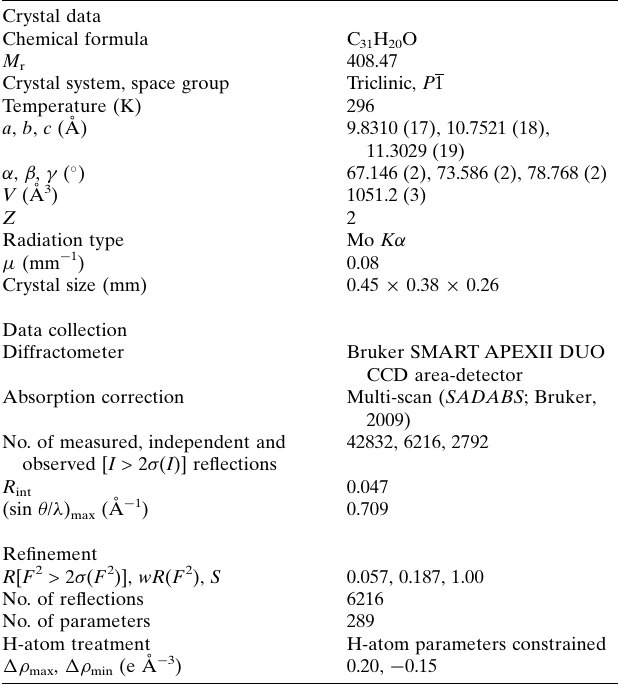
Table 2 Experimental details. Crystal data Chemical formula